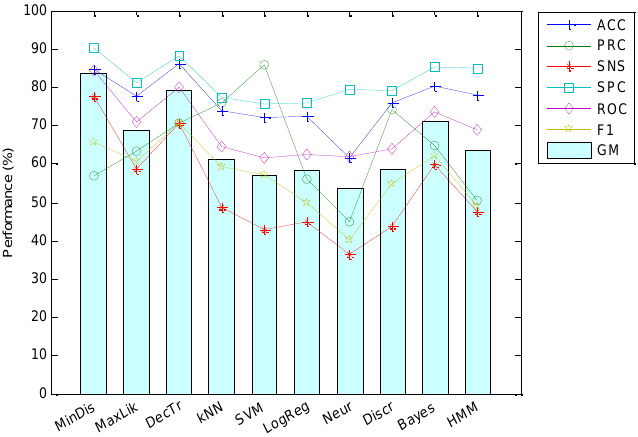
Figure 18. Classification performance using MPEG-7 features.